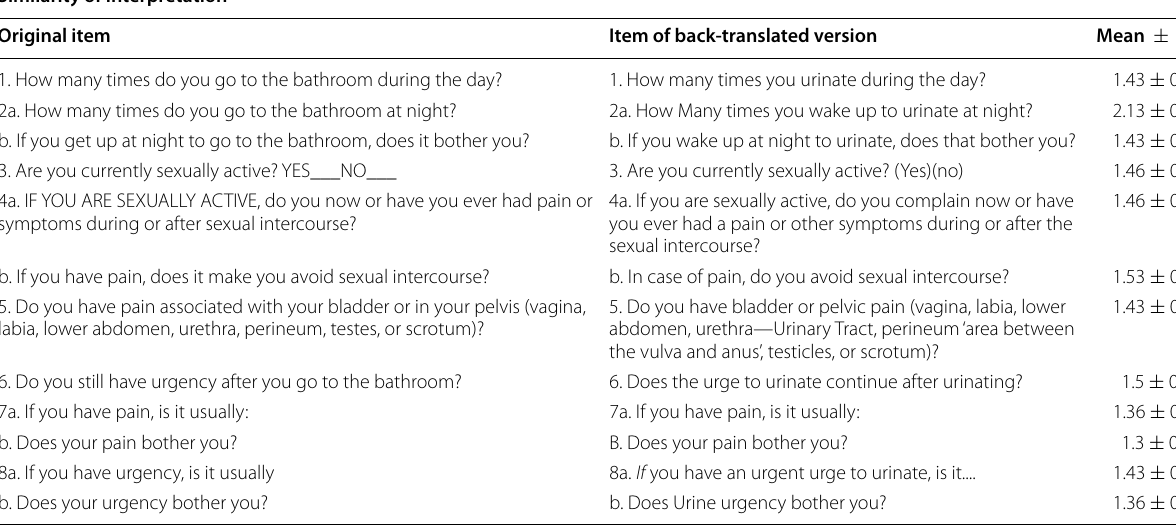
Table 2 Similarity of interpretation Similarity of